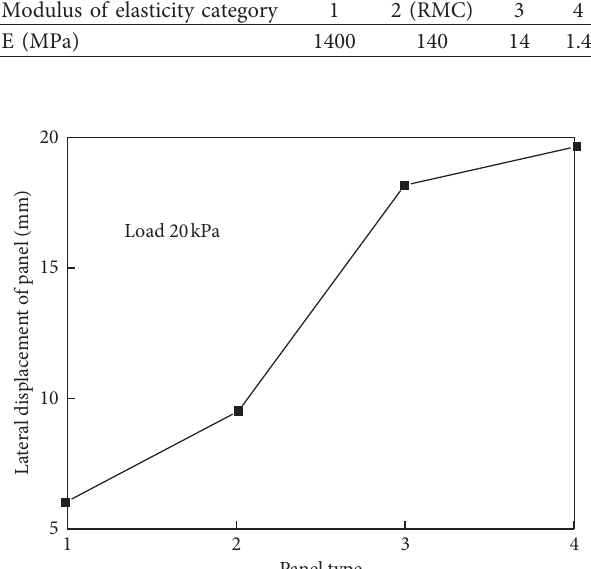
Figure 10: Dependence of the lateral displacement of the panel on its